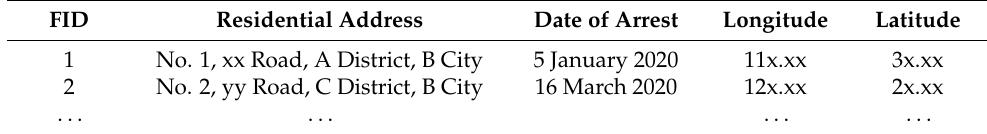
Table 1. Examples of offender residence